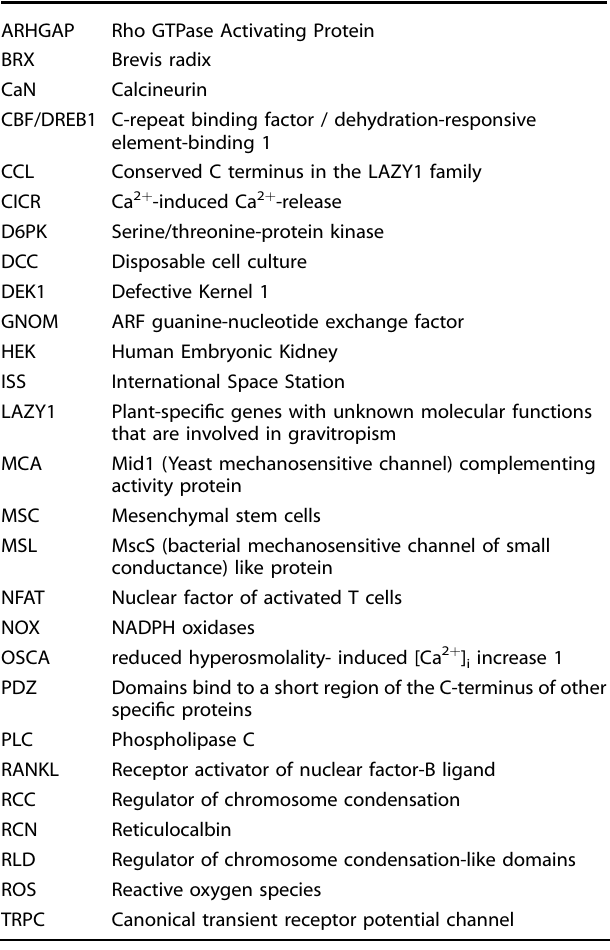
Table. 1. List of